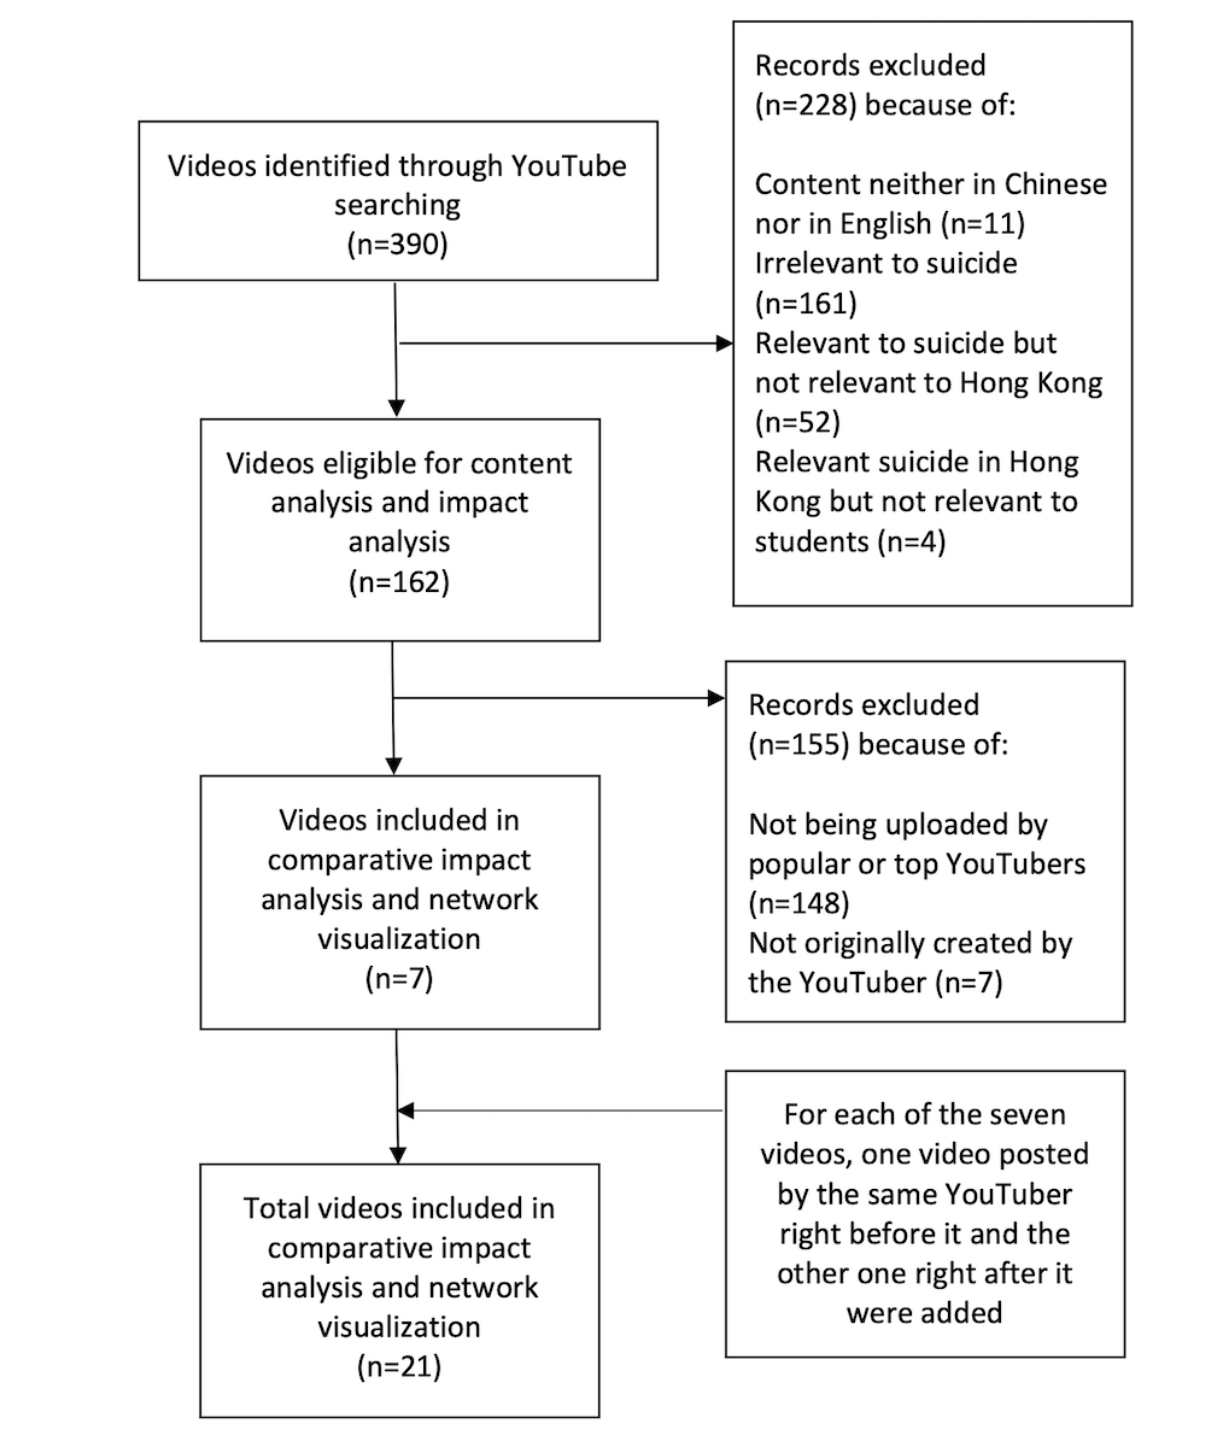
Figure 1. Procedure of video searching, screening, and